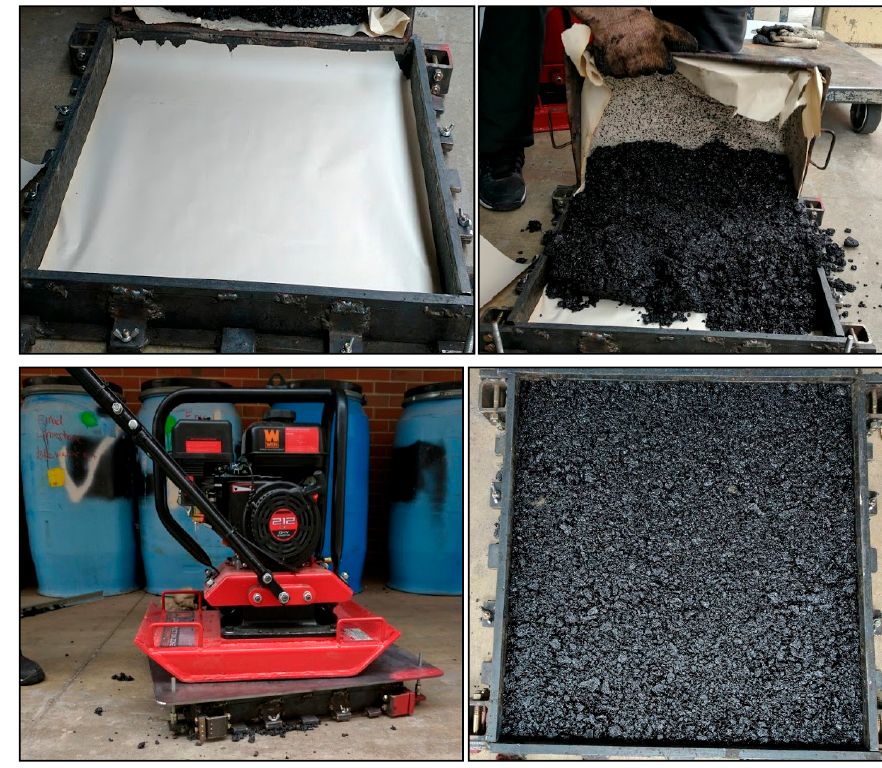
Figure 3. Preparing hot mix asphalt (HMA) slabs.